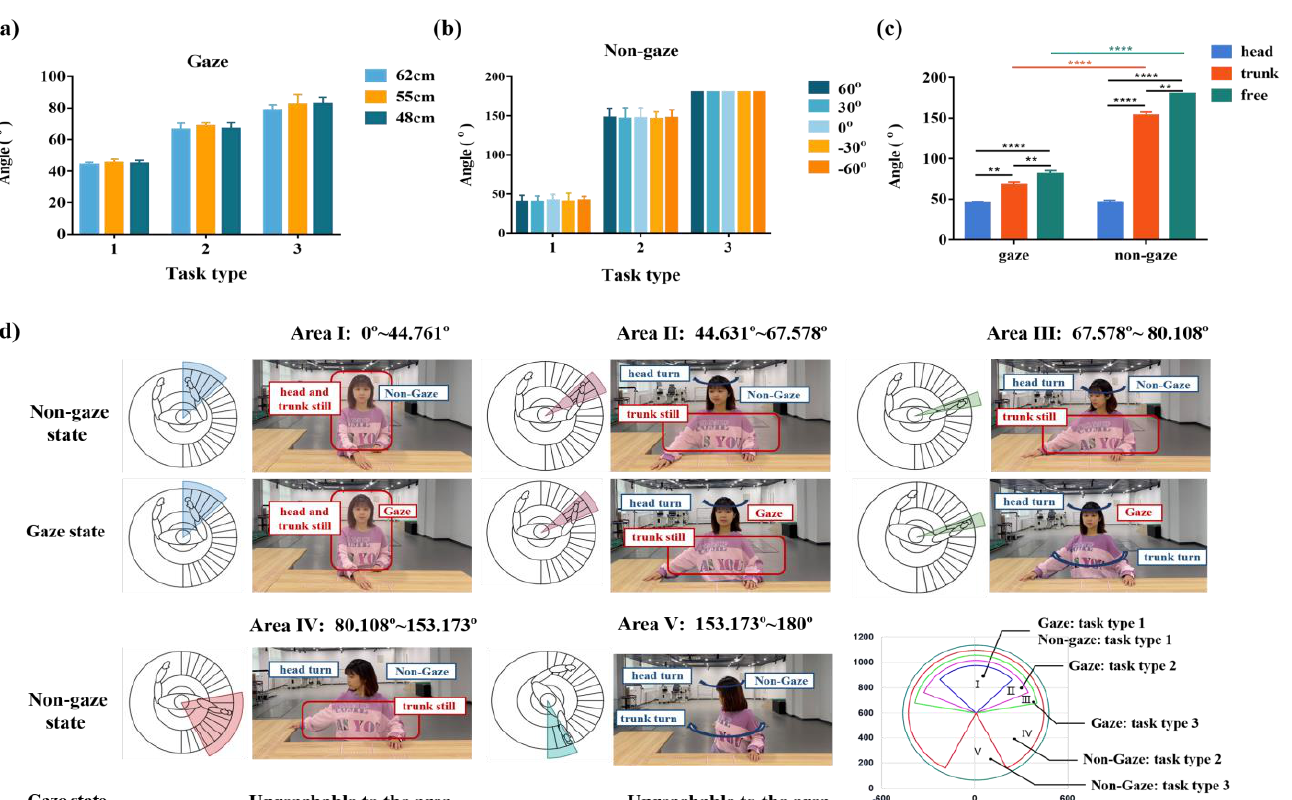
Figure 5. Task type 1 is keeping the head still, task type 2 is keeping the head and trunk still, and task type 3 is unlimited. ( a ) Mean ± SD of each area angle when height differs under the gaze state. There was no significant ( p > 0.05). ( b ) Mean ± SD of each area angle when the initial angle of the head differs under the non-gaze state. There was no significant ( p > 0.05). ( c ) Mean ± SD of each area angle when task type differs under the gaze and non-gaze state. ** denotes p < 0.01, and **** denotes p < 0.0001. The results of the visualization for each area’s extent and body pattern are shown in Figure 6 ( d ).